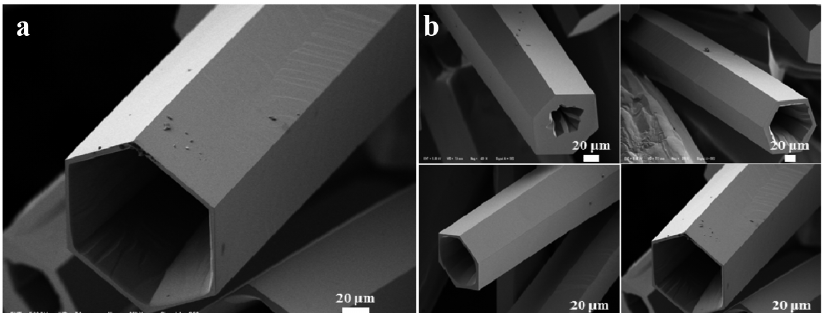
Figure 1: FE-SEM images of the Zn 0.99 Cd 0.01 O microtubes synthesized using microwave irradiation: (a) High magnification showing the hexagonal geometric faceted surfaces of the Zn 0.99 Cd 0.01 O microtube. (b) Different stages for growth process of